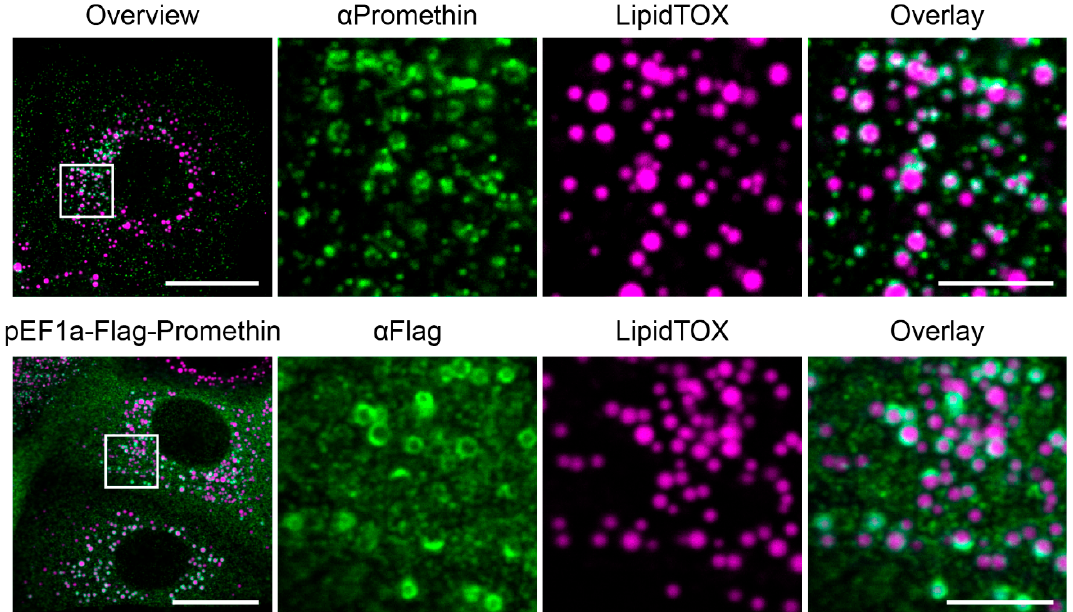
Figure 2. Promethin is an LD-associated protein. MCF7 cells treated with 200 µM oleic acid for 72 h were subjected to staining with the neutral lipid dye LipidTOX and immunofluorescence microscopy using an antibody directed against the C-terminus of human promethin ( top row). MCF7 cells transfected with a plasmid for expression of promethin-Flag were subjected to the same procedure using an antibody against Flag ( bottom row). Both native and expressed promethin localizes to lipid droplets (LDs). Scale bar, overview 20 µm; zoomed overlay, 5 µm.